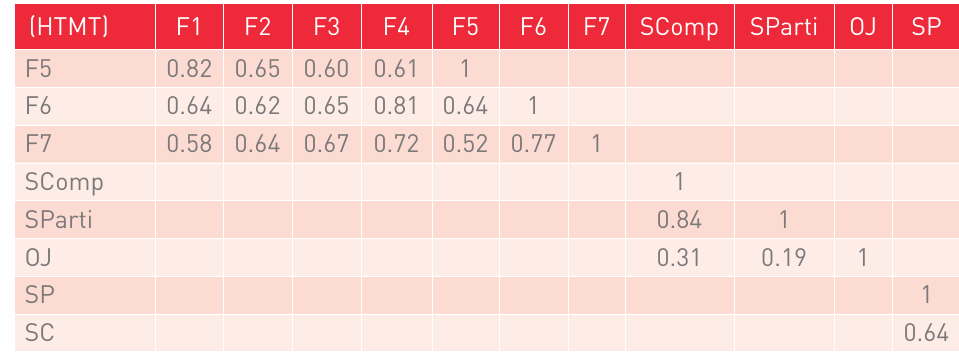
Safety Climate Factors between the current study and Kines et al. (2011)